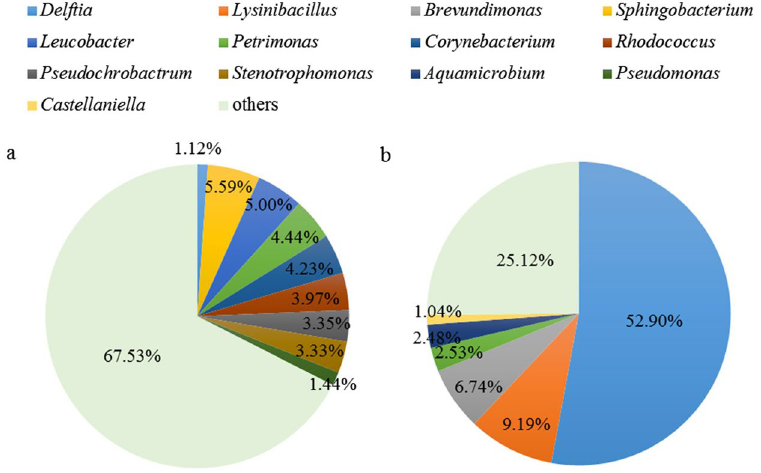
Figure 4. The relative abundance levels of genera in the microbial communities of the original activated sludge ( a ) and the enriched MMC ( b ). The genera with abundance less than 1% are classified into ‘others’.